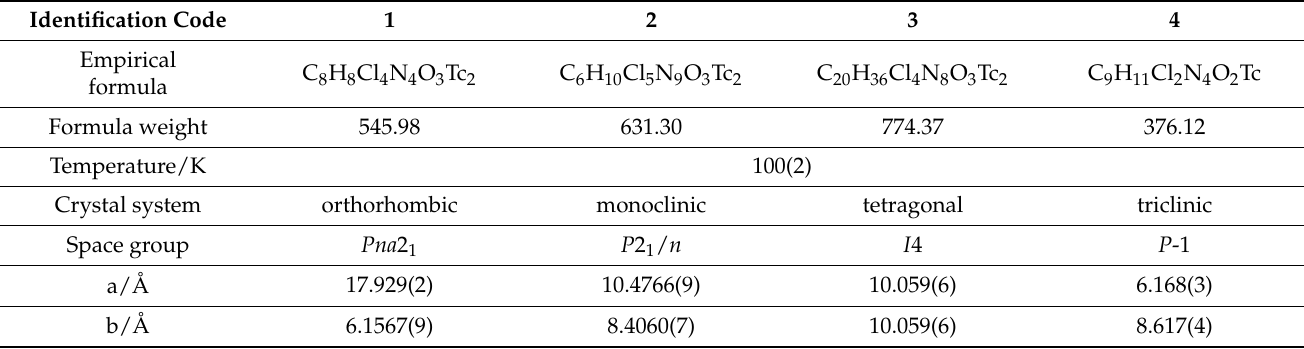
Table 1. Crystal data and structure refinement for structures 1 – 4